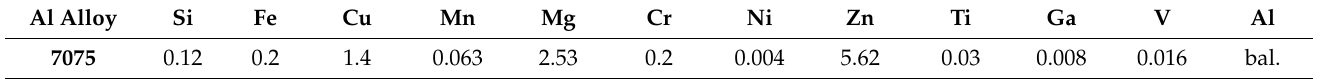
Table 2. Chemical composition of 7075 aluminum alloy.